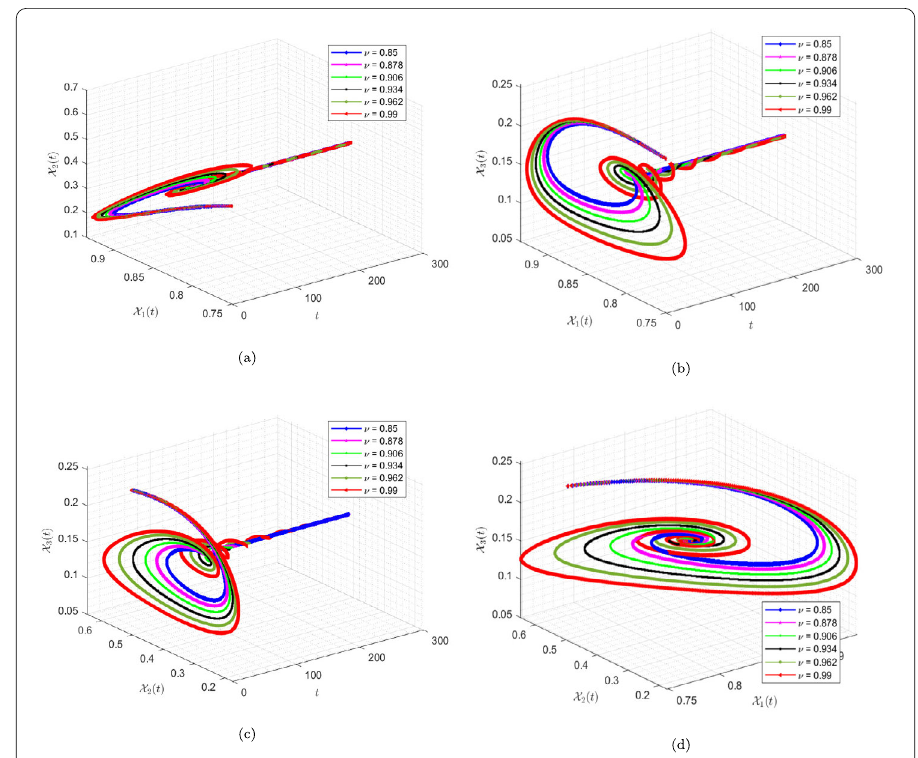
Figure 2 Dynamics for system (19) for different parameters in